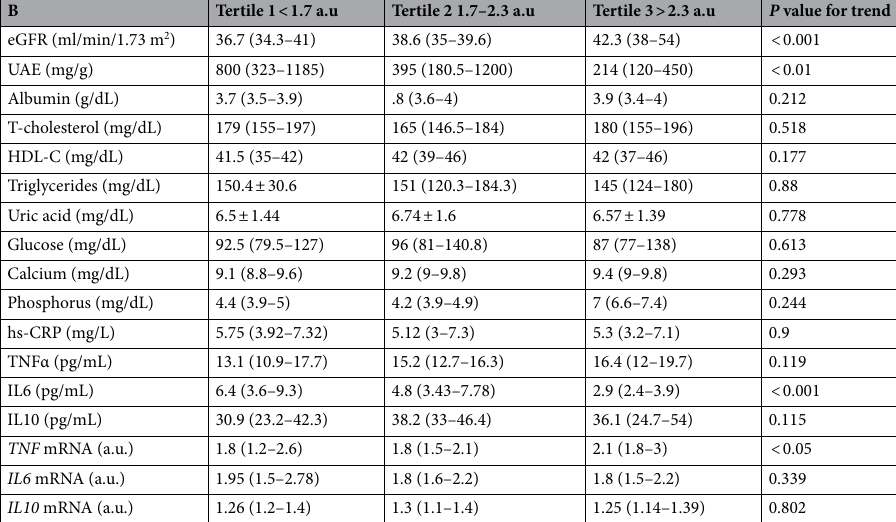
Table 2. Clinical characteristics and general biochemical assessments stratified by tertiles of serum Klotho (pg/mL) (A) or PBCs KL mRNA (a.u.) (B) levels. BP blood pressure, ABI ankle-brachial index, CIMT carotid intima-media thickness, sCVD subclinical cardiovascular disease, eGFR estimated glomerular filtrate rate, UAE urinary albumin excretion, T-cholesterol total cholesterol, HDL-C high-density lipoprotein cholesterol, hs-CRP high sensitivity C-reactive protein, TNFα tumor necrosis factor, IL